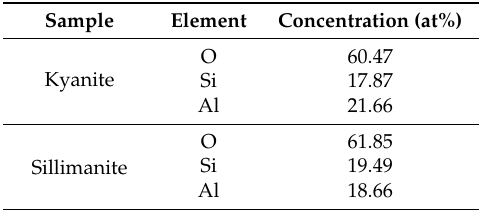
Table 2. XPS-derived surface concentrations (atomic% normalized to Al, O and Si) of kyanite and sillimanite.